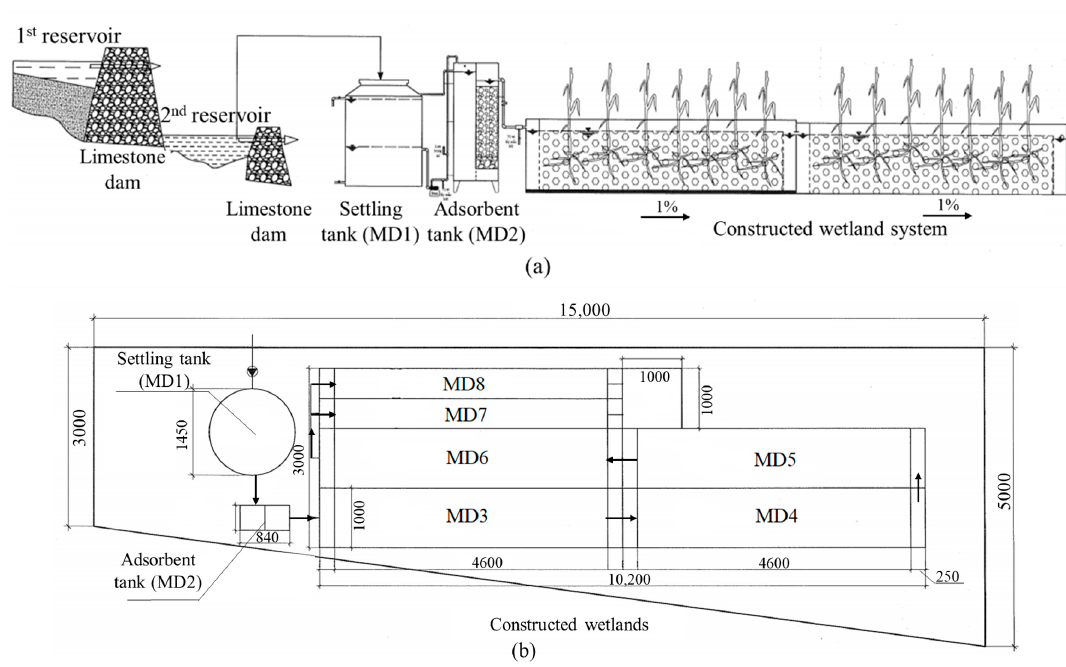
3 Table 1. Characteristics of adsorbent and substrates. BET: Brunauer–Emmet–Teller, PCD: Particle Charge Detector. Material Characteristics